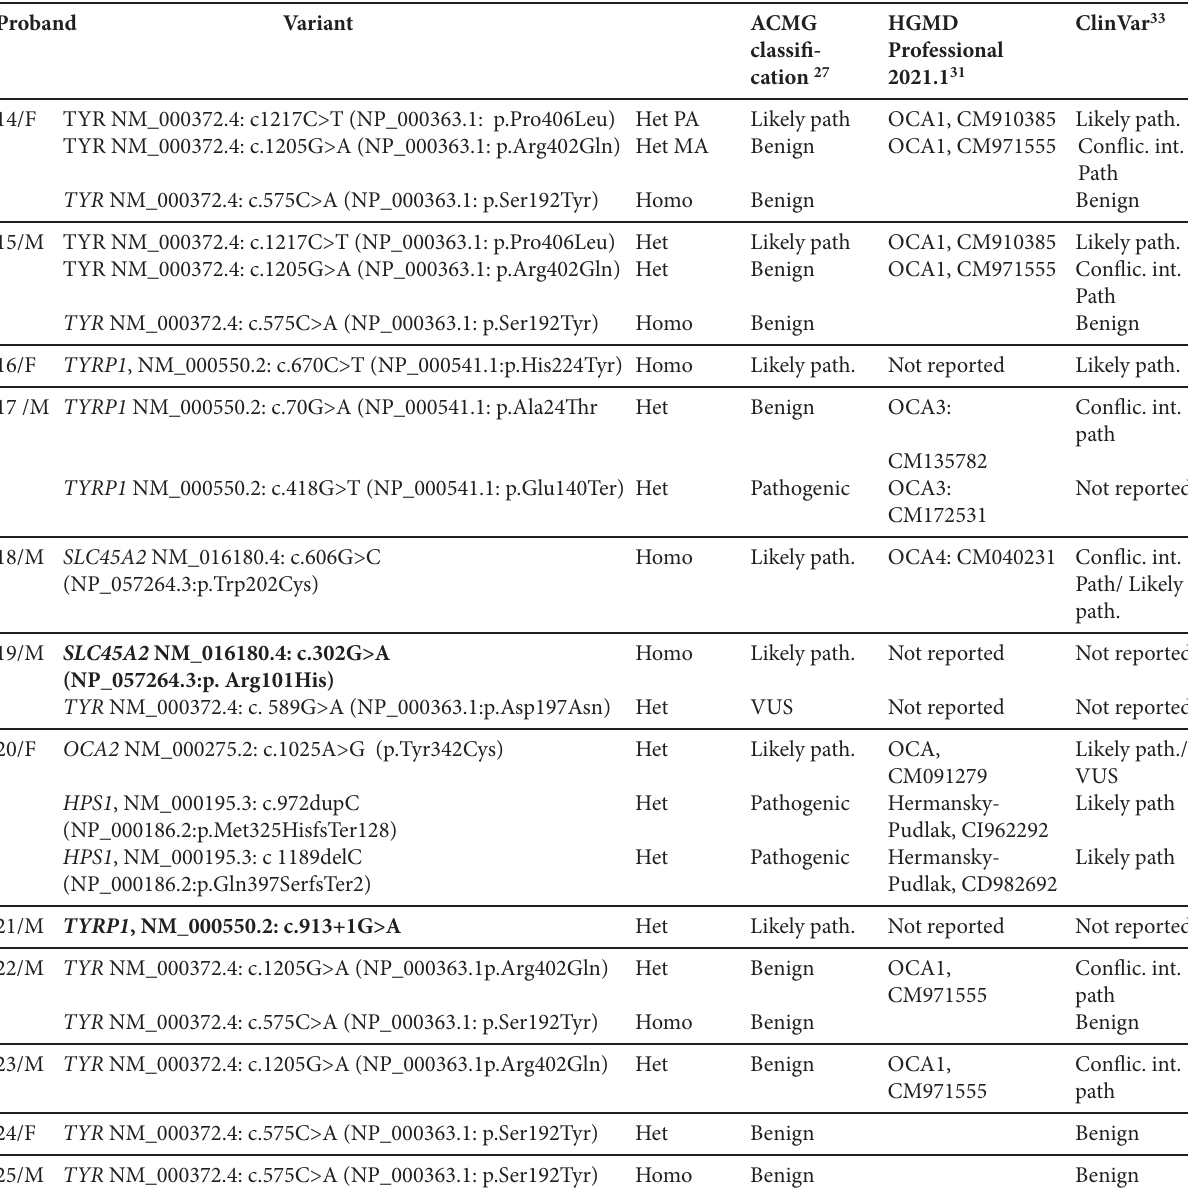
Table 3: General population frequencies and in silico prediction scores of the novel genetic variants detected in OCA patients (REVEL 29 , VEST4 30 and SpliceAI 31 values O-1, and CADD 28 Phred values: variants with higher scores are predicted to be more likely pathogenic; nd: not detected)